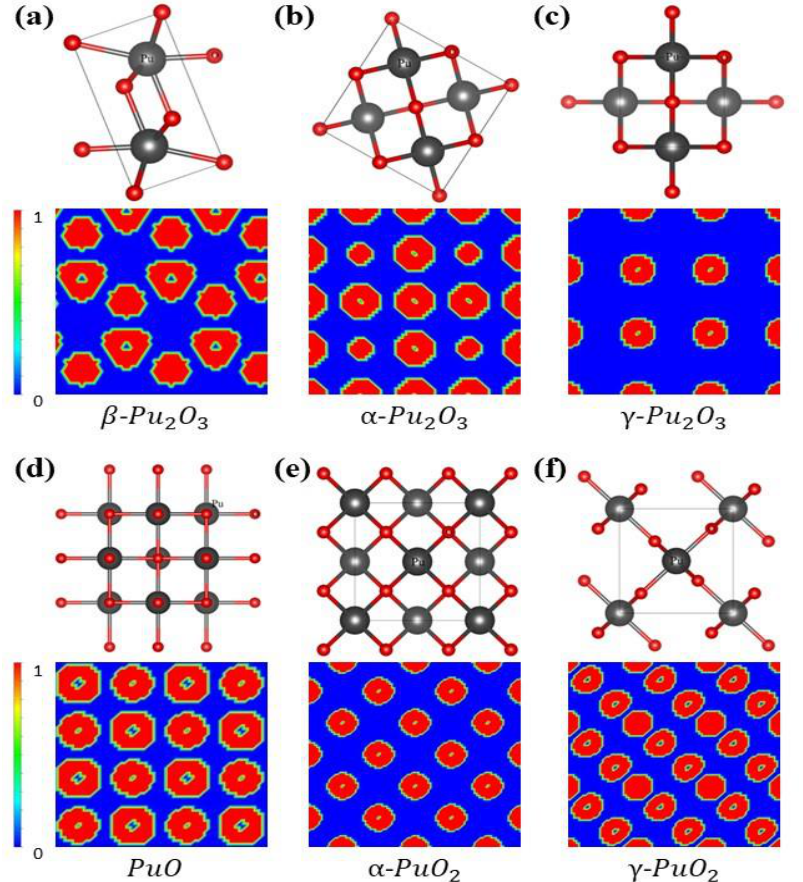
Figure 1. Optimized geometries of ( a ) β -Pu 2 O 3 , ( b ) α -Pu 2 O 3 , ( c ) γ -Pu 2 O 3 , ( d ) PuO, ( e ) α -PuO 2 , ( f ) γ -PuO 2 are shown in the figure above. The gray atoms indicate the Pu atoms. The red atoms indicate O atoms. Their local electronic density states are also listed. Pu and O atoms are represented in blue and red color,